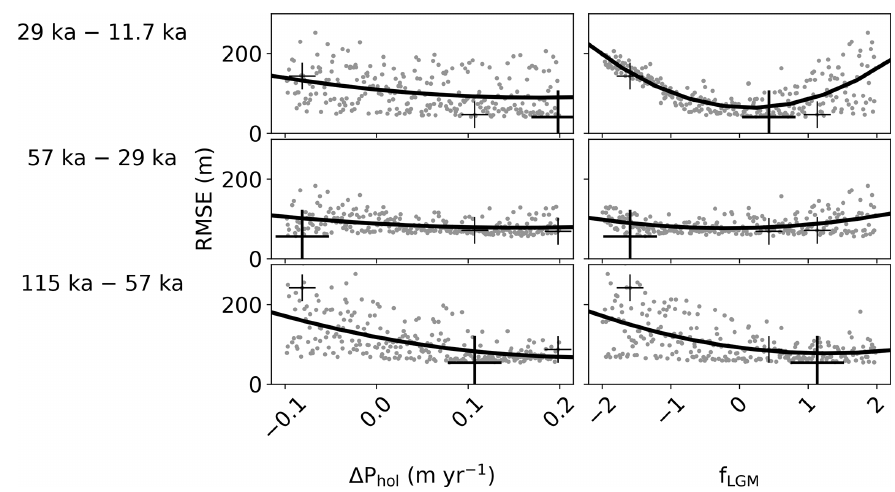
Figure 10. Like Fig. 8, but for differences between isochrones. Note the different scale on the vertical axis.